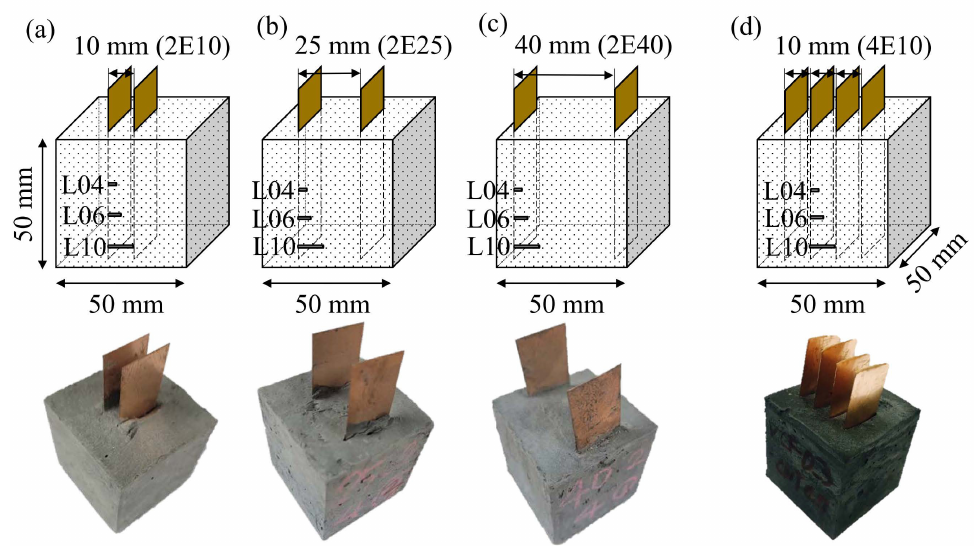
Figure 2. Schematic diagram of the probe configurations of the cement composites; ( a – c ) cement composites with di ff erent electrode spacings in the two-probe configuration and ( d ) cement composite with 10 mm electrode spacing in the four-probe configuration. L04, L06, and L10 correspond to the CF filament lengths of 4, 6, and 10 mm, respectively. In Figure 2a–c, 2E10, 2E25, and 2E40 indicate the electrode spacings of 10, 25, and 40 mm, respectively, in the two-probe configuration. In Figure 2d, 4E10 indicates the electrode spacing of 10 mm in the four-probe